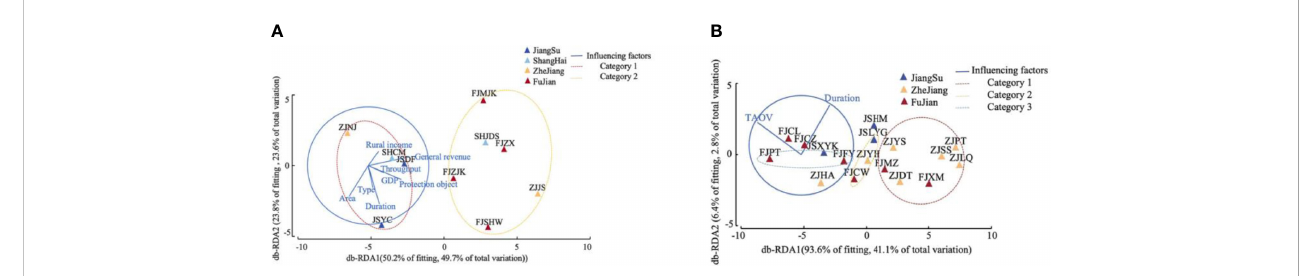
FIGURE 4 Drivers affecting the effectiveness of protected area management: (A) MNRs; (B) MSRs. ( ‘ Rural income ’ means ‘ Disposable income of urban permanent residents ’ ; ‘ General revenue ’ means ‘ General public budget revenue ’ ; ‘ Throughput ’ means ‘ Container throughput ’ ; ‘ Type ’ means ‘ Type of protected area ’